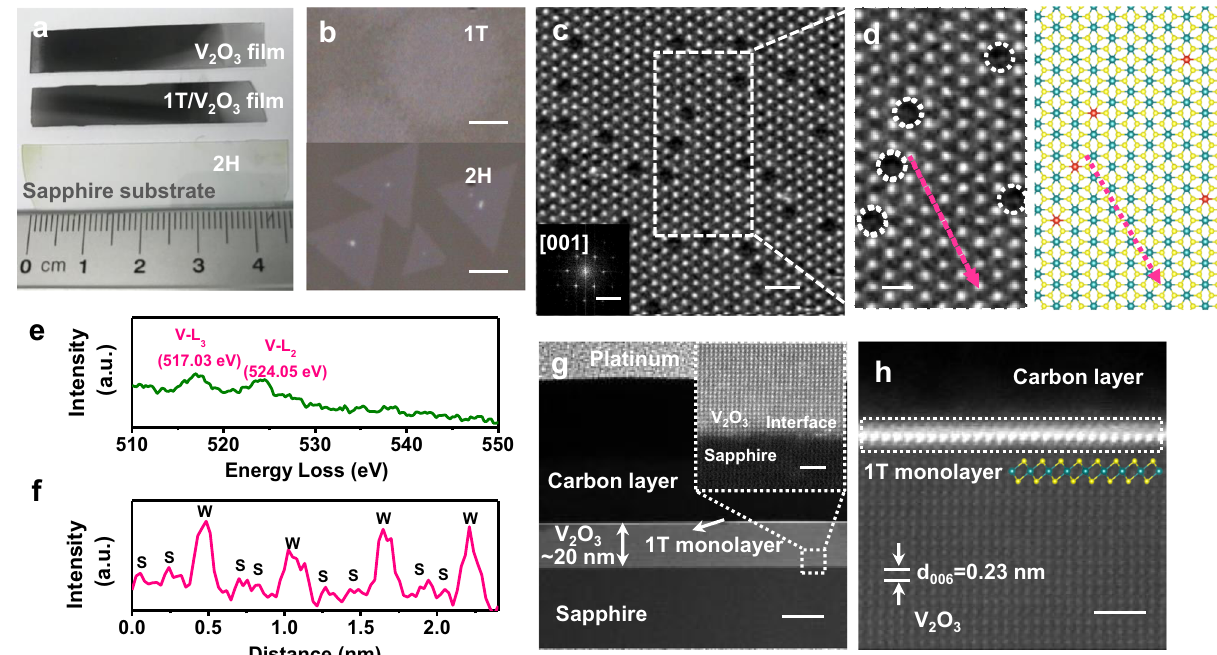
Fig. 2 Characterization of V SACs@1T-WS 2 monolayers. a Pictures of different materials formed on the sapphire substrates. Up: V 2 O 3 fi lm; Middle: V SACs@1T-WS 2 /V 2 O 3 fi lm; down: 2H-WS 2 . b Optical micrographs of as-grown V SACs@1T-WS 2 (up) and 2H-WS 2 (down) grown by CVD. c High-resolution HAADF-STEM image for the V SACs@1T-WS 2 . Inset: the corresponding fast Fourier transform (FFT) of ( c ). d Left: zoom-in high- resolution STEM image for the V SACs@1T-WS 2 indicated by ( c ). Right: the schematic model of V SACs@1T-WS 2 . The blue spheres, yellow spheres, and red spheres represent the W atoms, S atoms, and V atoms, respectively. e EELS spectrum of vanadium element in the V SACs@1T- WS 2 monolayer. f Intensity pro fi les of the pink dashed arrow indicated by Fig. 1d. g Low-resolution cross-section HAADF-STEM image of V SACs@1T-WS 2 /V 2 O 3 fi lm on the sapphire substrate. Inset: the interface between V 2 O 3 and sapphire substrate. h High-resolution HAADF-STEM image of V SACs@1T-WS 2 on the V 2 O 3 fi lm; scale bars: ( b ) up: 10 µ m, down: 5 µ m; ( c ) 1 nm, inset: 5 1/nm; ( d ) 0.5 nm; ( g ) 20 nm, inset: 1